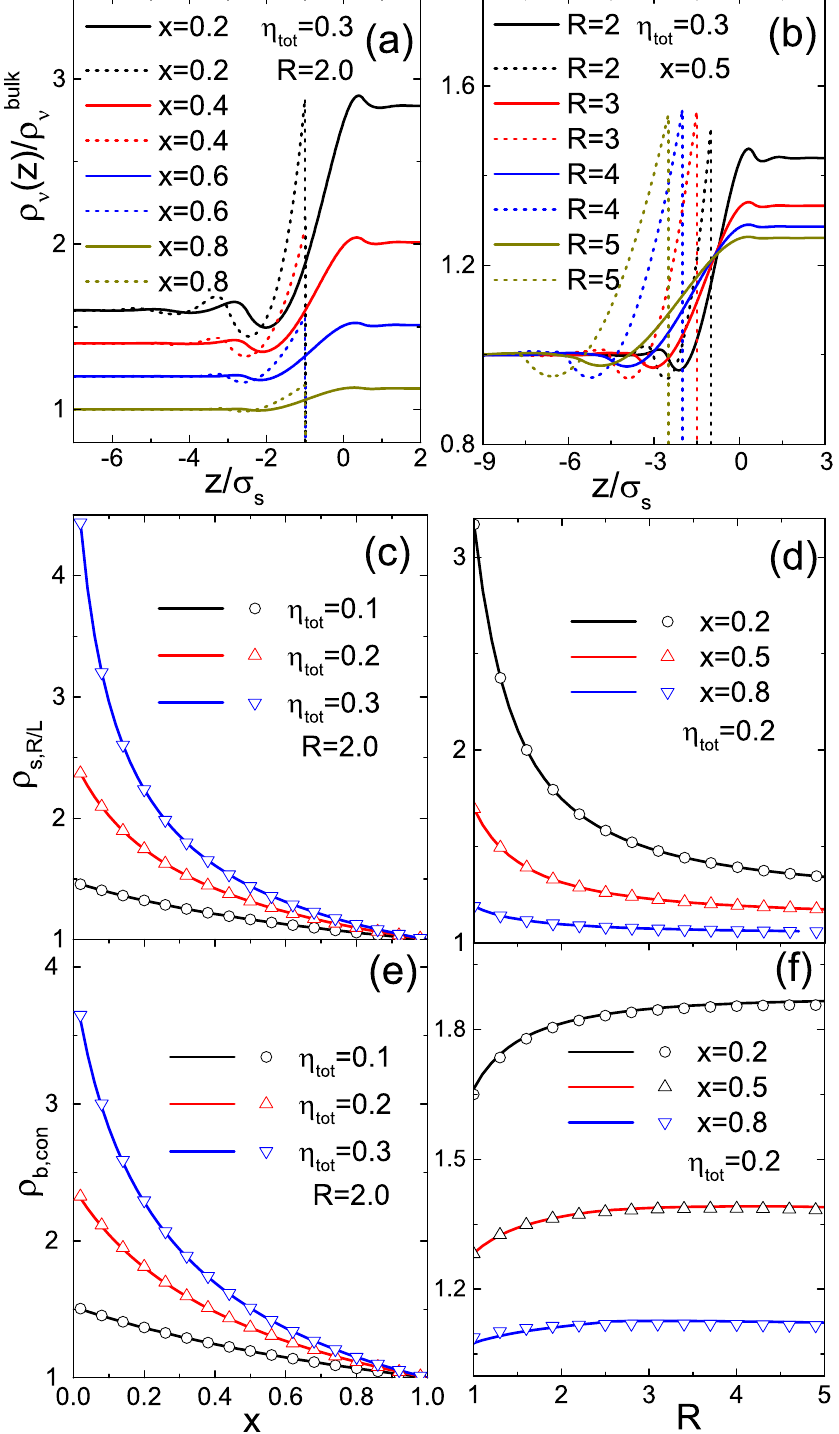
Figure 2. ( a , b ): Density profiles of the mixture under different conditions of x and R . ( c , d ): ρ s , R / L under different conditions. ( e , f ): ρ b , con under different conditions. Note that in ( a ), the results for x = 0.2, 0.4, 0.6 have been consecutively shifted upward by 0.2, and that in both ( a , b ), the solid and dashed lines correspond respectively to the results for the small and big components. In ( c , f ), the solid lines is the results from the DFT calculations, while the symbols from the analytical